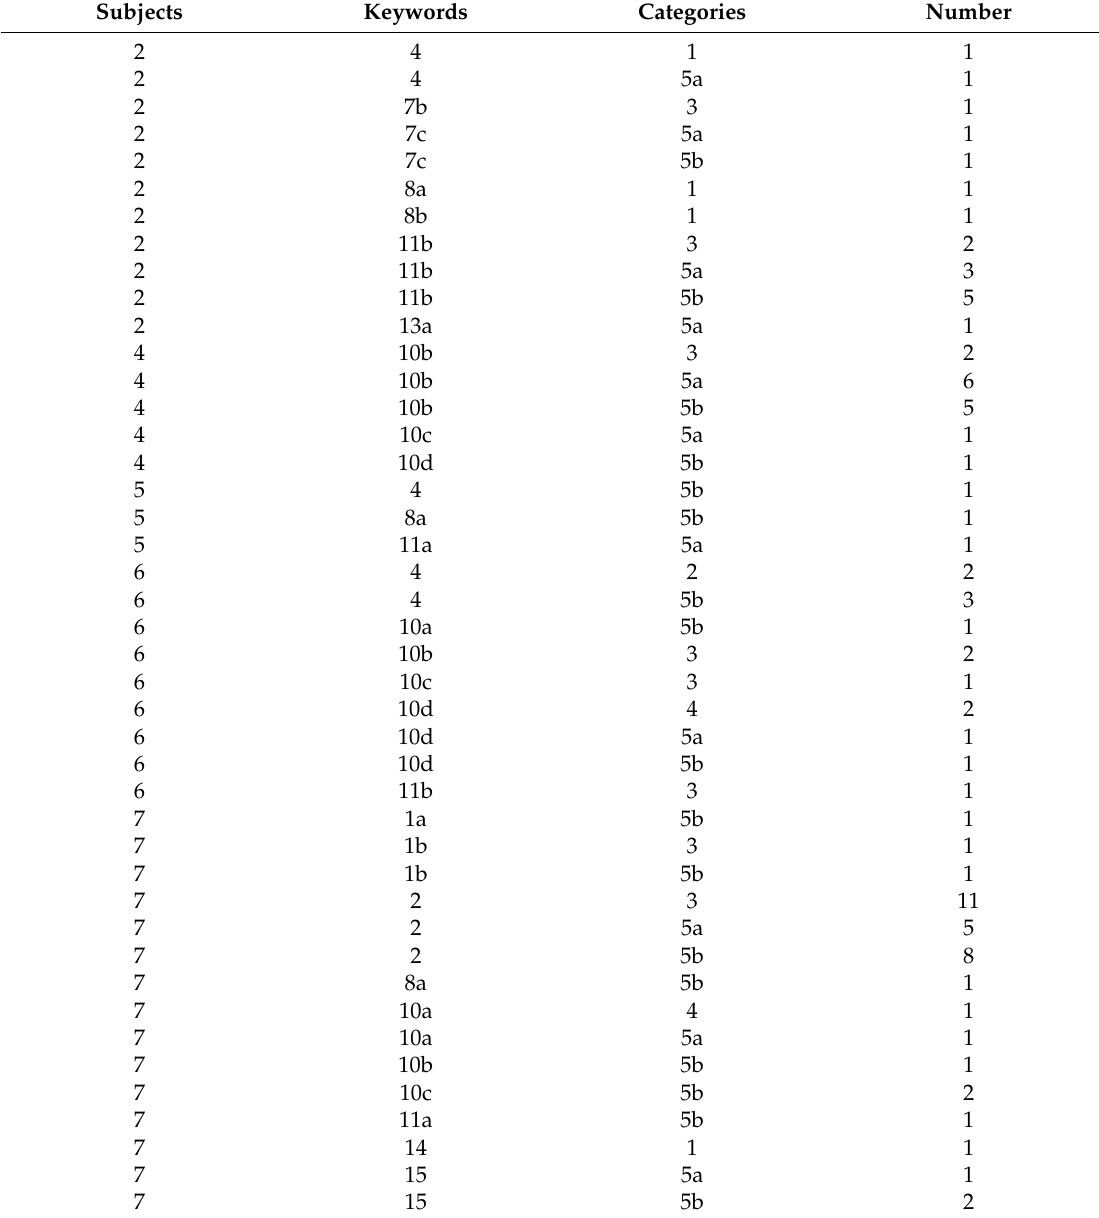
Table A4. Full results: Chartered Community of